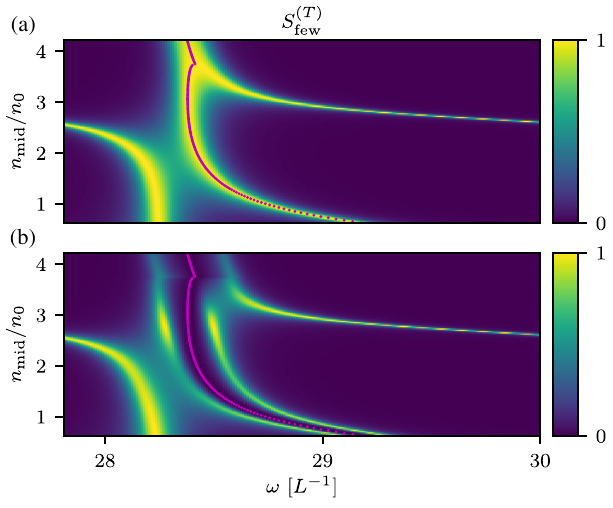
FIG. 11. Linear transmission spectra for the double Fabry-Perot cavity in Fig. 10 as a function of the central mirror refractive index, calculated using the ab initio few-mode theory with a single system mode ( χ 9 ). (a) shows the empty cavity without an atom. A transition between different regimes featuring an avoided crossing is observed. In (b), results of the interacting system with an atom at the center of the first cavity are shown. The atom ’ s resonance frequency is chosen resonant with the empty cavity spectral peak, indicated by the magenta dots. A splitting of the resonant cavity mode is observed, with interesting features in the transition regions. The shown few-mode results are found to agree well with linear dispersion theory in both